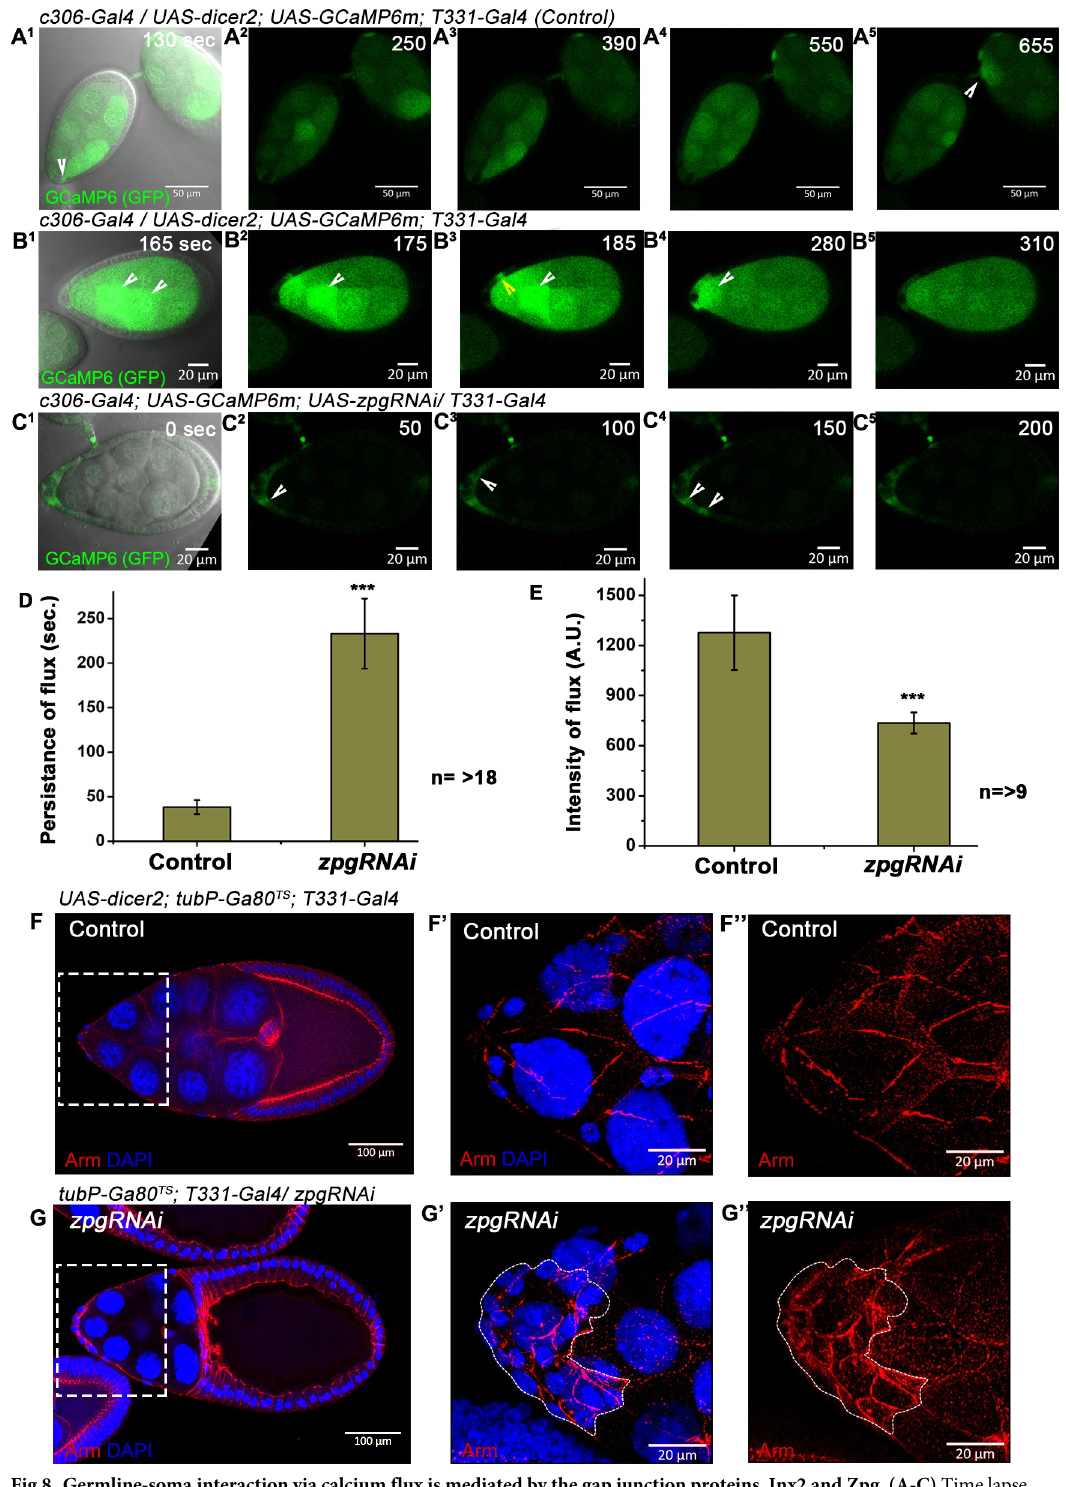
Fig 8. Germline-soma interaction via calcium flux is mediated by the gap junction proteins, Inx2 and Zpg. (A-C) Time lapse imaging of the egg chambers depicting calcium flux in the indicated genotypes. (A 1 -A 5 ) Please note the sporadic instances of calcium flux in the nurse cells. Arrowhead in A 1 indicates the flux in the nurse cells and adjacent follicle cell are coincident. Please note the follicle cell flux in A 4 precedes gradual flux build up in the neighboring Nurse cell (Arrowhead in A 5 ). Note the flux signal in the Nurse cells is gradually extending from the side facing the follicle cells towards its center. (B 1 -B 5 ) Indicates instances of flux